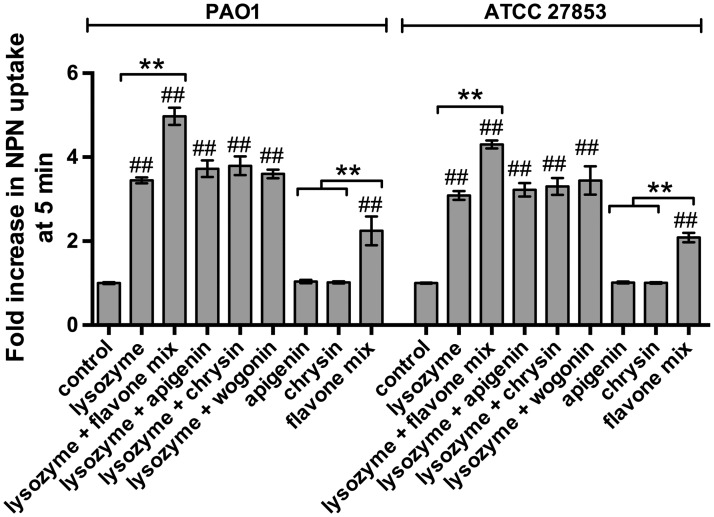
Confirmation of bacterial cell wall damage by NPN uptake.Bacteria were incubated for 5 min with lysozyme ± flavones as indicated and described in the text, followed by measurement of NPN fluorescence, reflecting uptake of NPN into the bacterial phospholipid membrane. Data are expressed as fold increase in NPN fluorescence. Raw fluorescence values are in S1 File. Significance determined by one-way ANOVA with Bonferonni post-test; # and ## indicate p <0.05 and p <0.01, respectively, compared with control; ** indicates p <0.01 between bracketed groups.